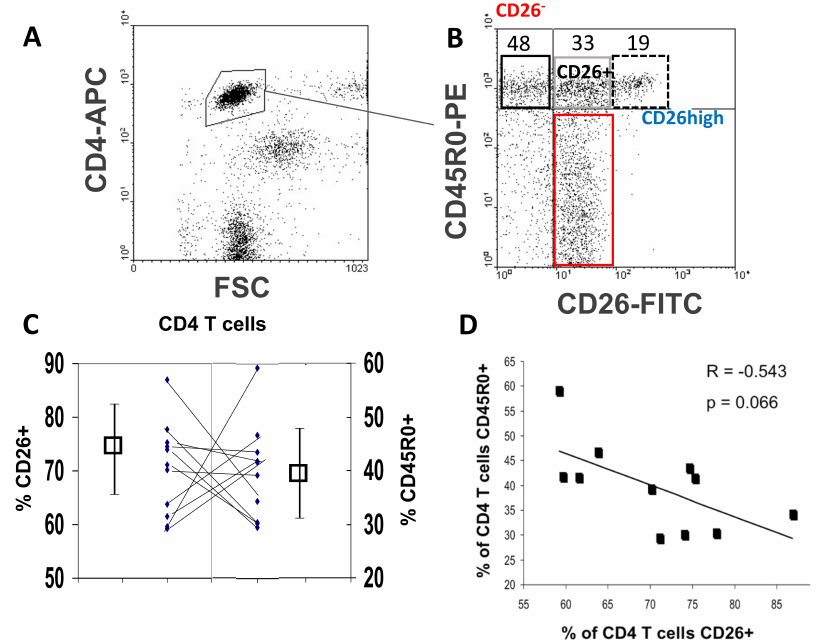
Figure 1. Cell-surface CD45R0 and CD26 in the CD4 T cells. ( A ) Representative ( n = 11) flow cytometry dot-plot showing lymphocytes gated physically on FSC and CD4 (controls are shown